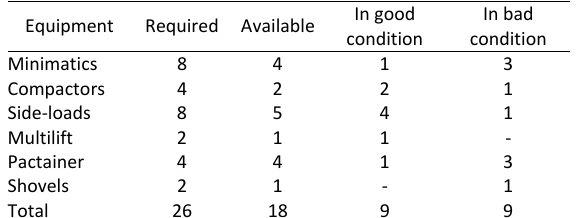
Table 6. Status of transportation vehicles (The Director of Environment and Enforcement, 2018)